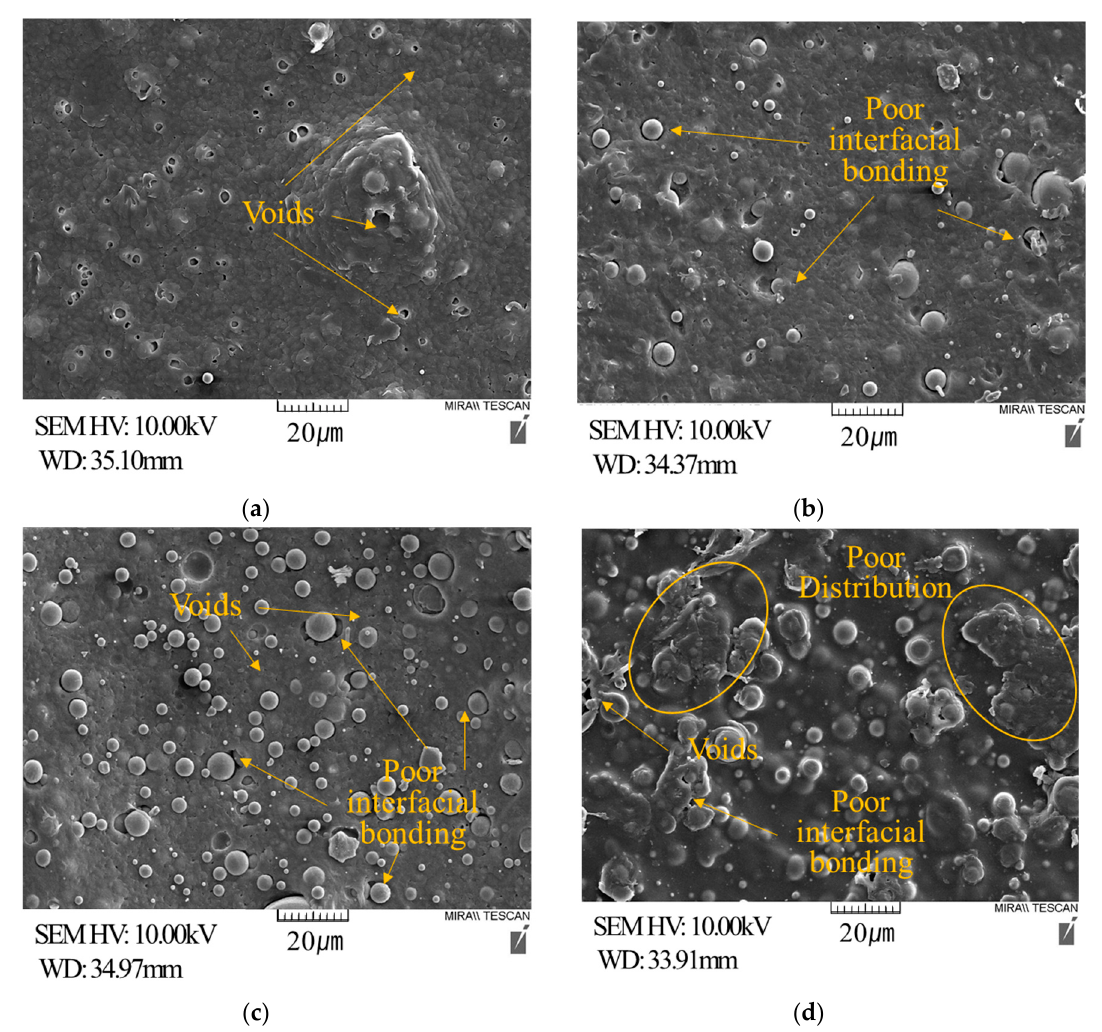
Figure 5. SEM images of the reinforced composites with various ratios. ( a ) PA6 (50); ( b ) PA6 (60); ( c ) PA6 (70); ( d ) PBT (60).